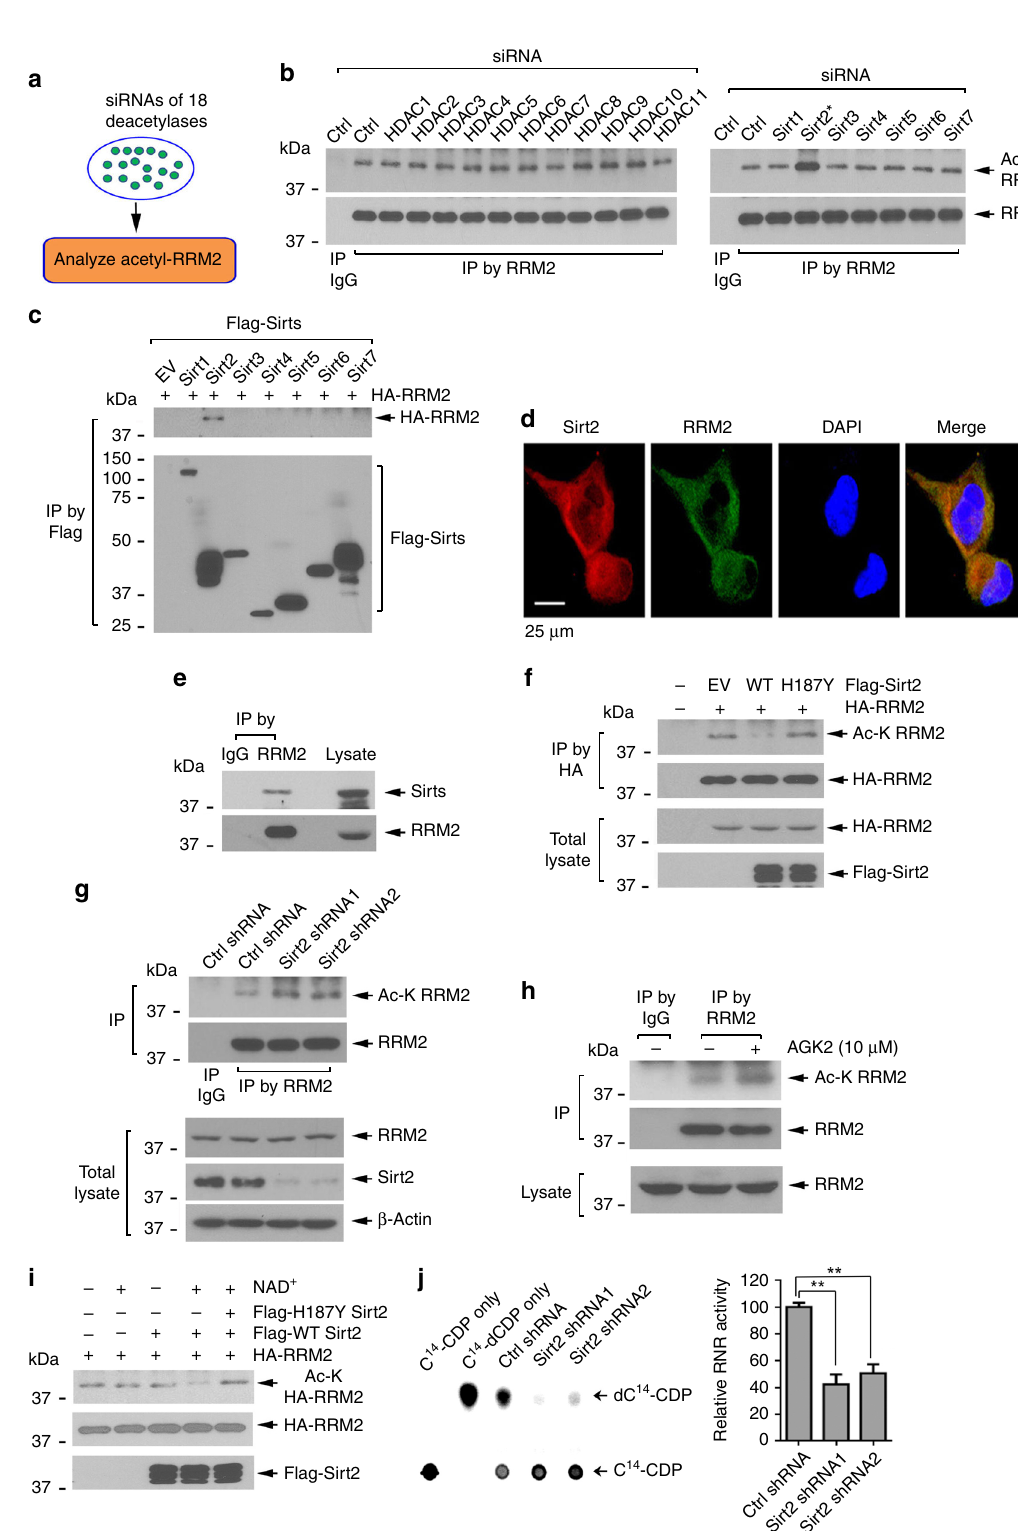
Flag antibody. Although different sirtuins were overexpressed to different levels, only Sirt2 among seven sirtuin family members was observed to interact with RRM2 (Fig. 4c). Moreover, endogenous